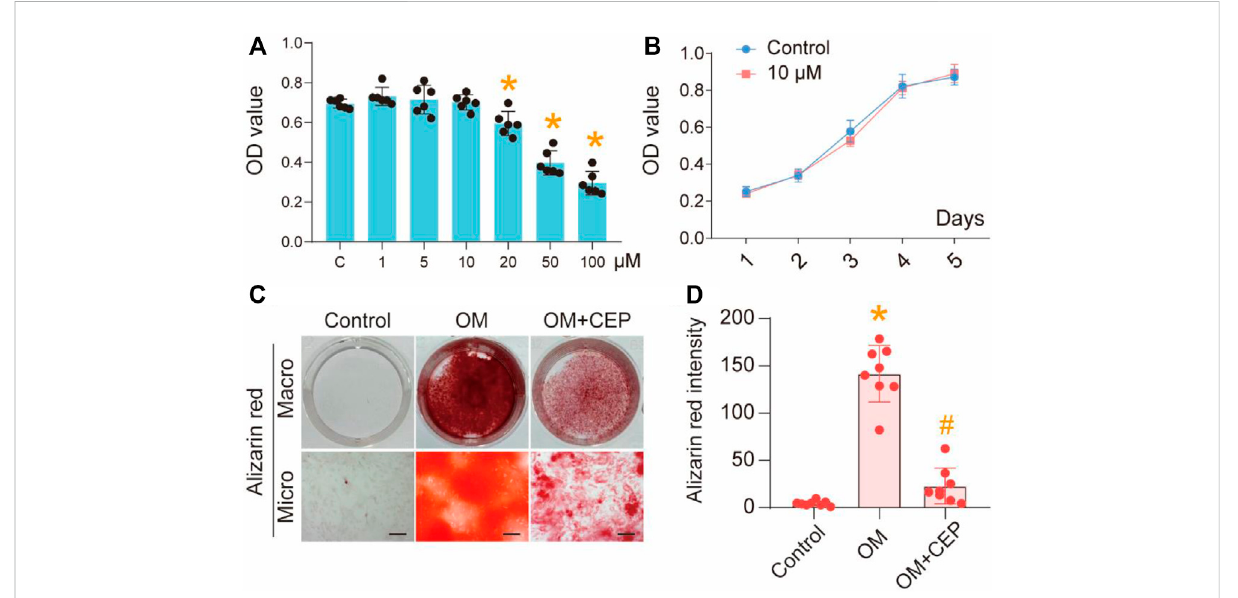
FIGURE 1 CEP inhibits osteogenic differentiation of VICs. (A) CCK8 assay of VICs with 1 – 100 μ M CEP treatments, (*) p < 0.05 vs. C (control); (B) Cell proliferationtestingwith10 μ MCEPtreatment; (C) AlizarinredstainingofOM-inducedVICswithorwithoutCEPtreatment,scalebar:50 μ m; (D) The intensity of alizarin red, statistical analysis. (*) p < 0.05 vs. control, (#) p < 0.05 vs. OM indicate signi fi cant